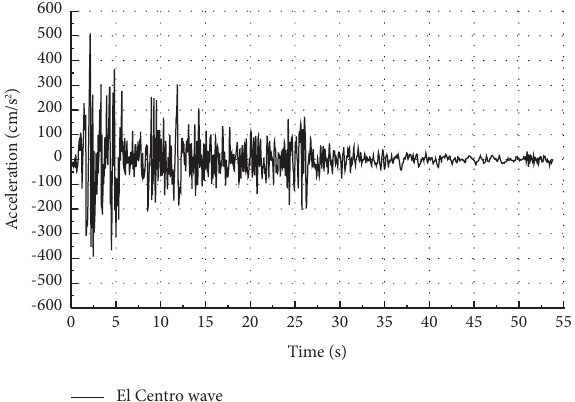
Figure 6: Time-history curve of El Centro waves.